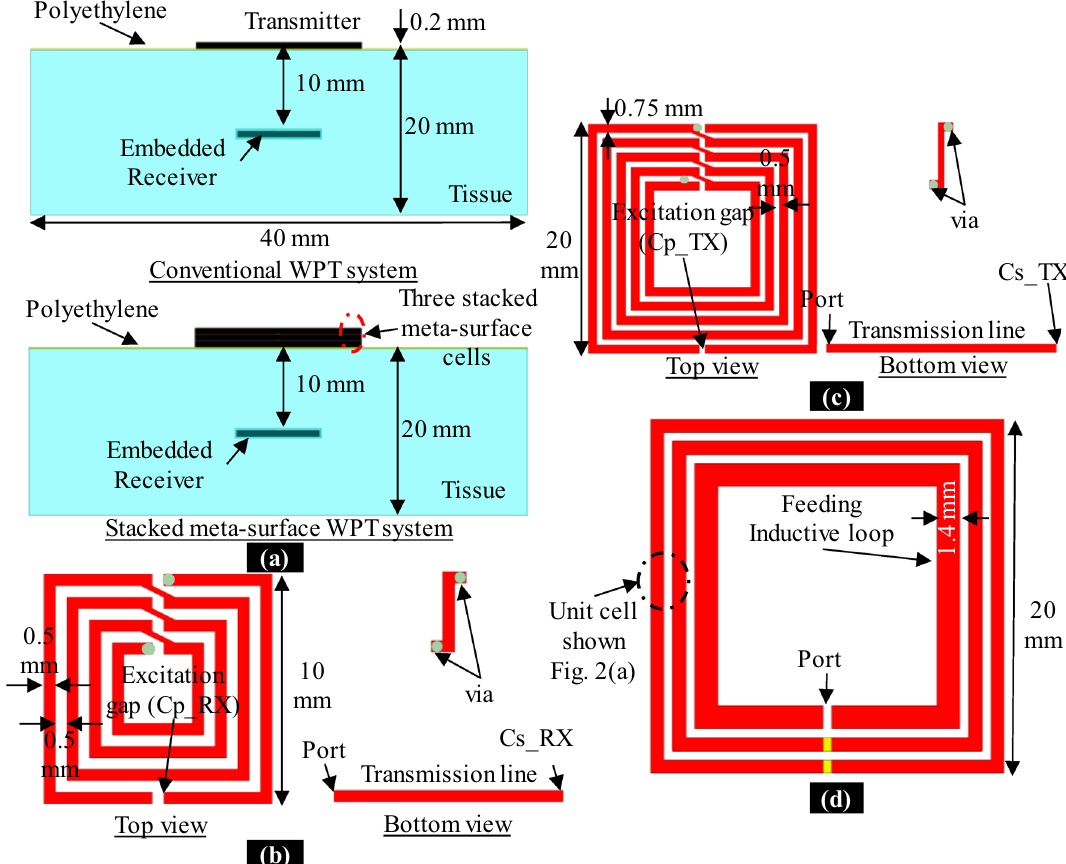
Figure 3. Conventional and proposed stacked metamaterial WPT systems in tissue. (a) Side view. (b) Layout of the RX in both cases. (c) Layout of conventional TX. (d) Layout of